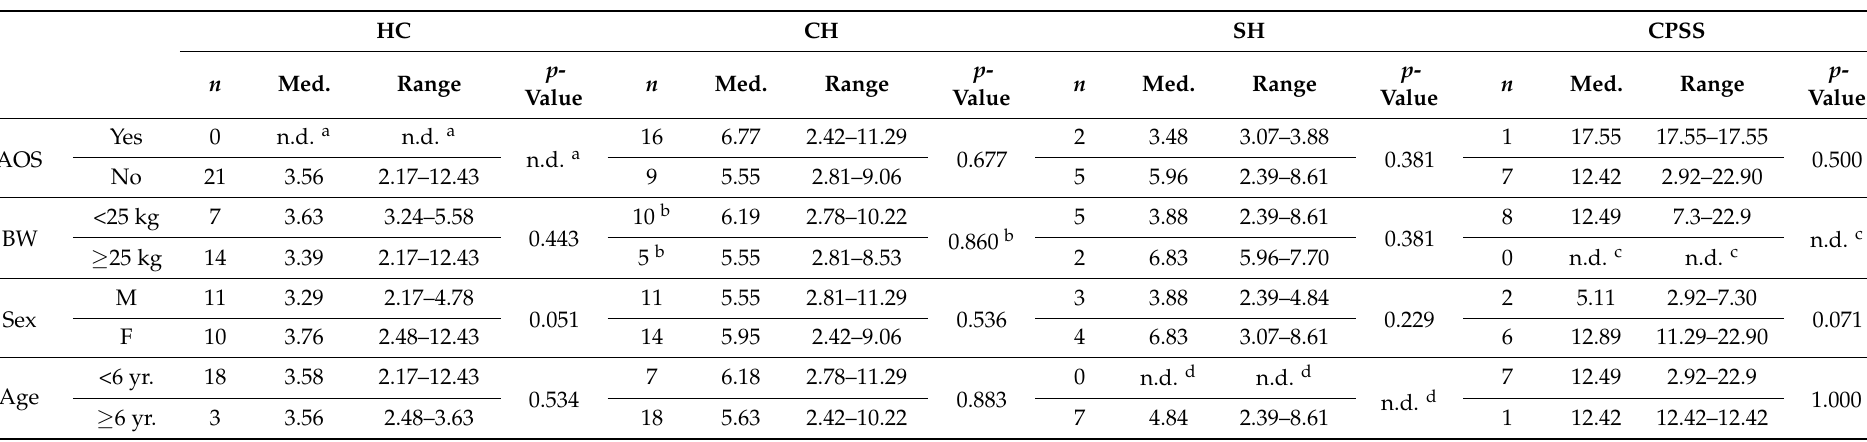
Table 2. Comparisons of within-group effect of antioxidant supplementation status, bodyweight, sex, and age on median urinary 15-F 2t -isoprostane concentrations (ng/mg